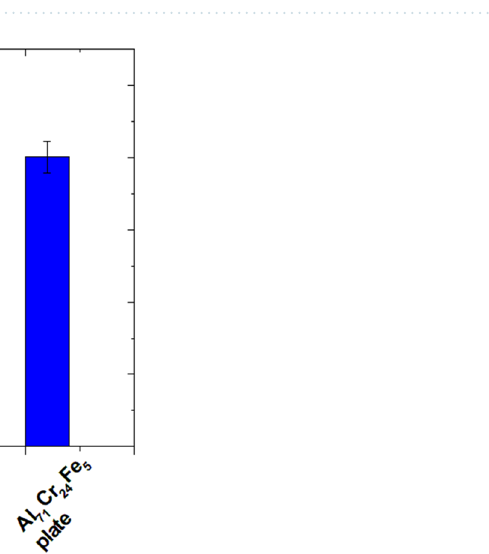
Figure 7. Surface morphology of the pin-on-disc friction track of ( a , b ) Al 65 Cr 20 Fe 15 , ( c , d ) Al 71 Cr 24 Fe 5 alloys in a form of ingots.